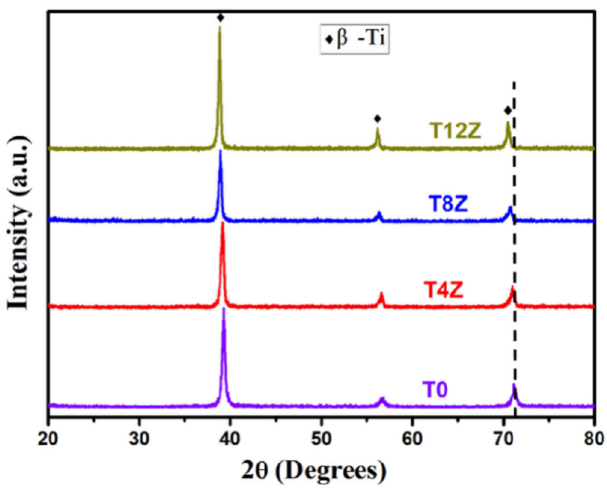
Figure 7. The XRD patterns of Ti-30Mo-0.5TiC-xZr alloys.